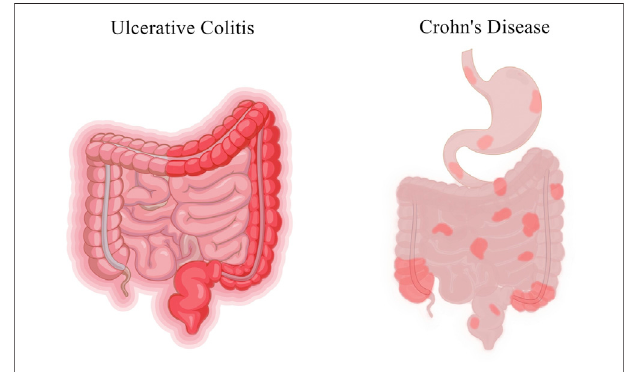
FIGURE 1 | The common affected parts of IBD.